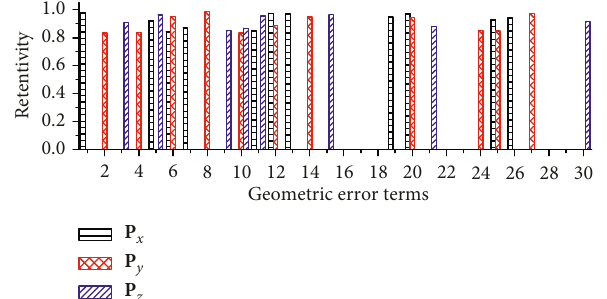
Figure 7: Accuracy retentivity analysis for the position vector at t